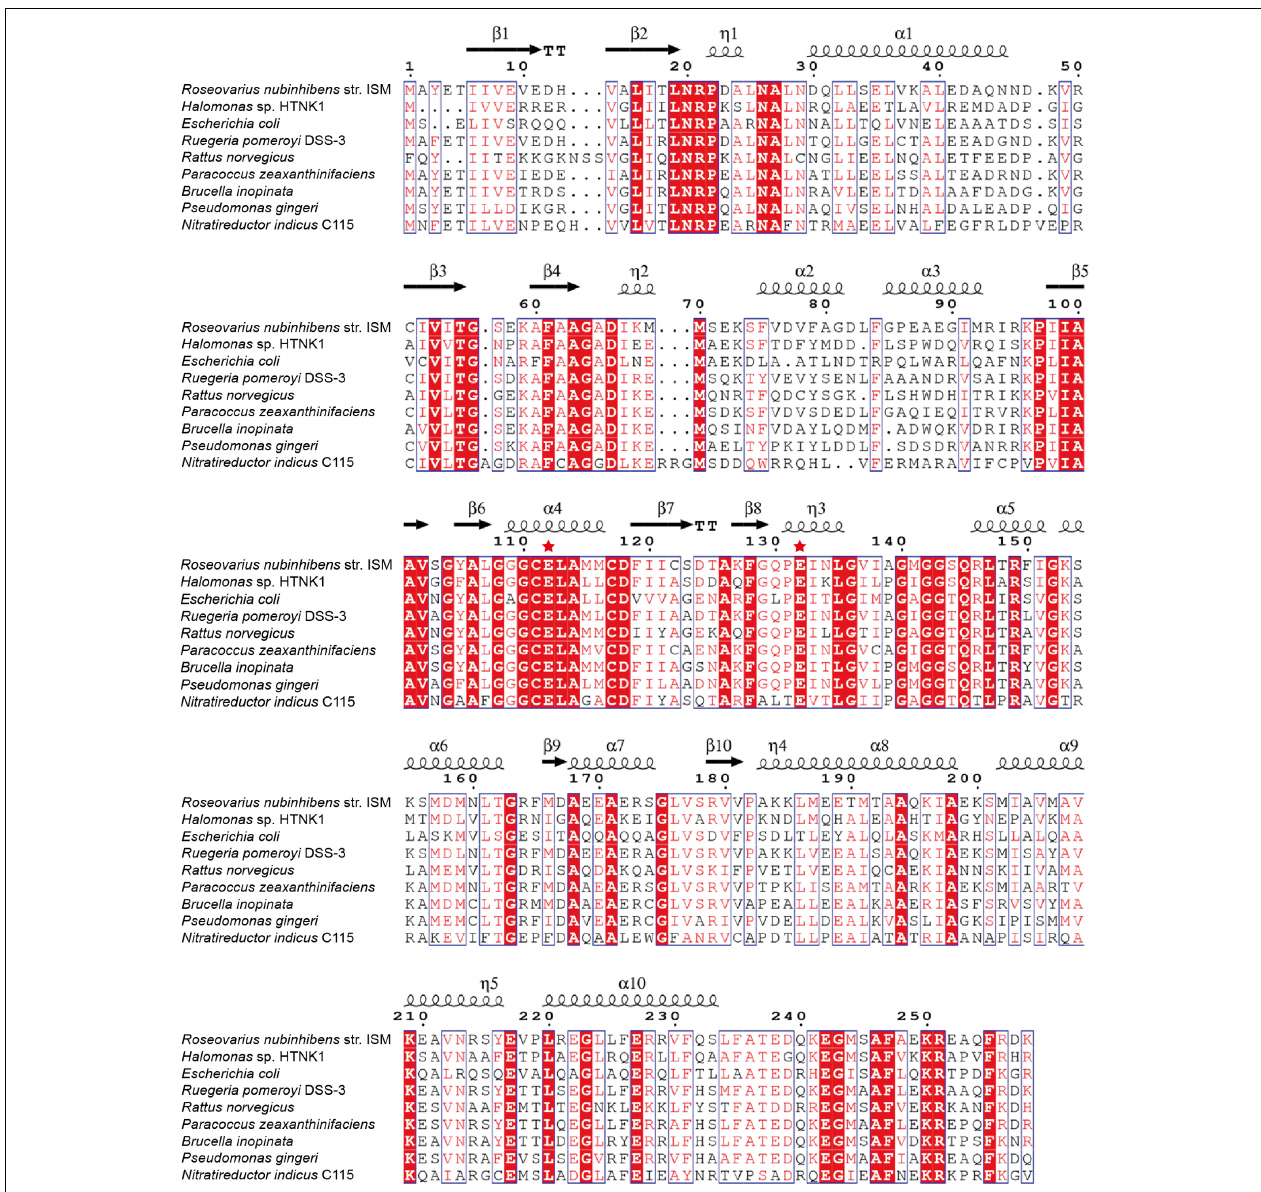
FIGURE 2 | Sequence alignment of Rd AcuH with other enoyl-CoA hydratases. Red filled boxes represent identical residues. The putative catalytic residues are marked by red stars. Picture was generated using ESPript 3.0 (Robert and Gouet,